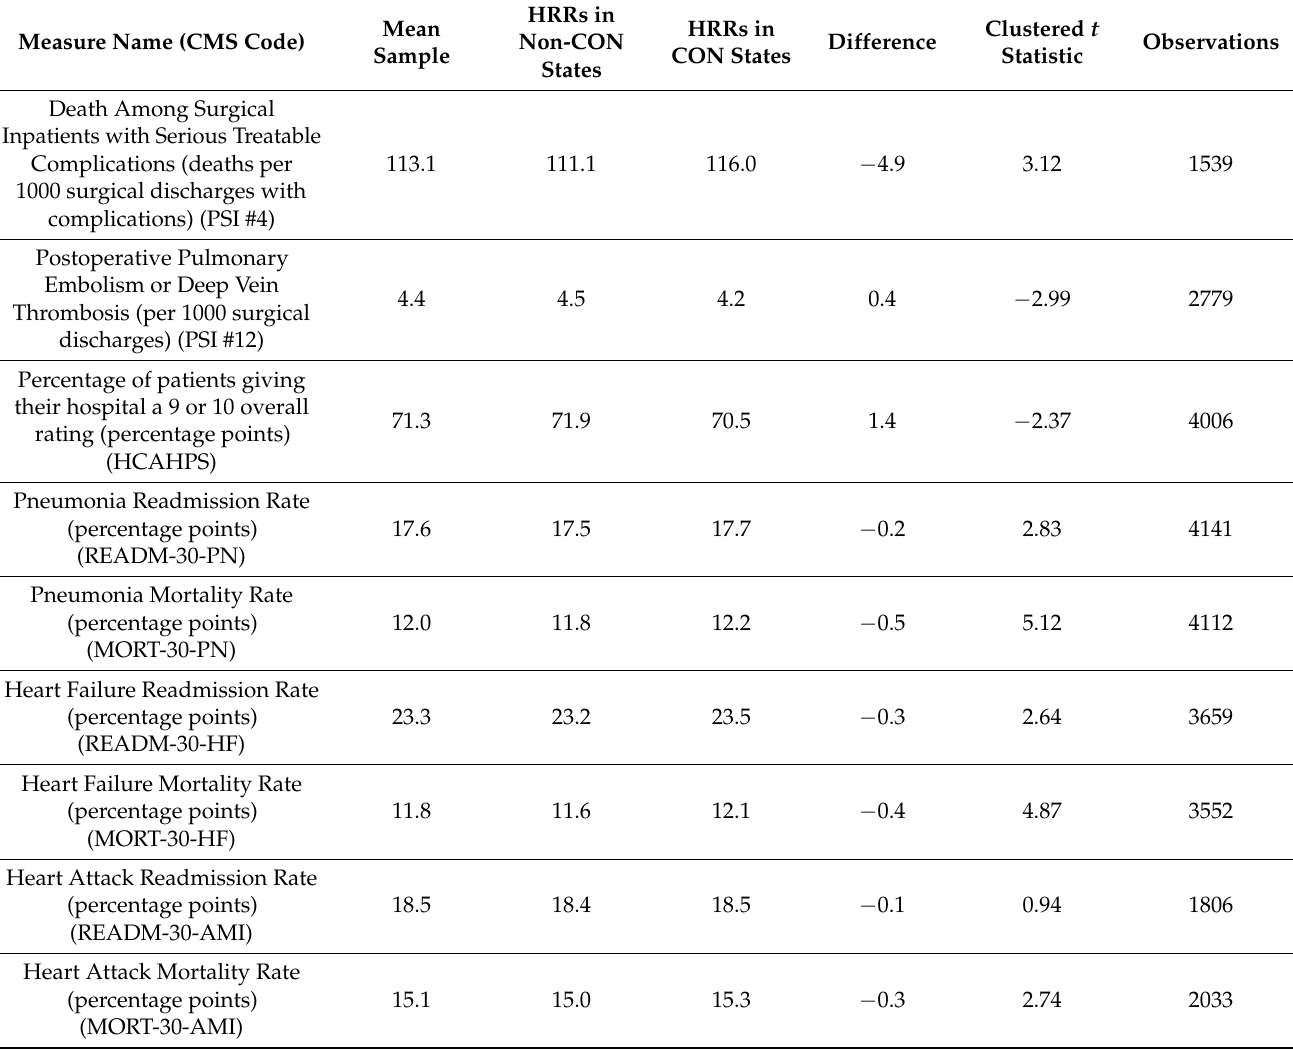
Table 6. Differences-in-means tests: hospital quality indicators for HRRs in both CON and non-CON states